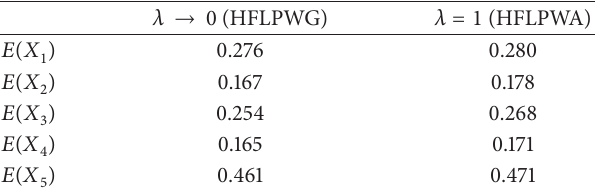
Table 3: The score values for the alternatives.